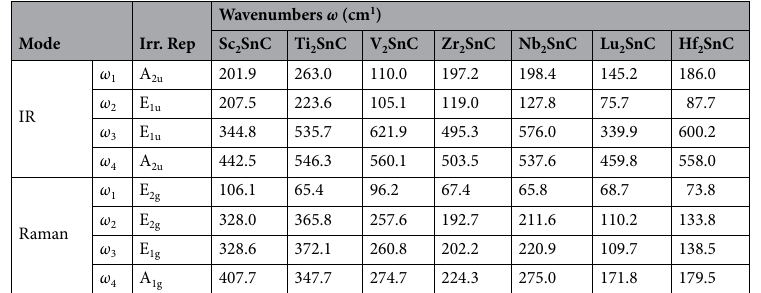
Table 2. Theoretical wavenumbers ω and symmetry assignment of the IR-active and Raman-active modes of the Sn-based M 2 SnC MAX phases.